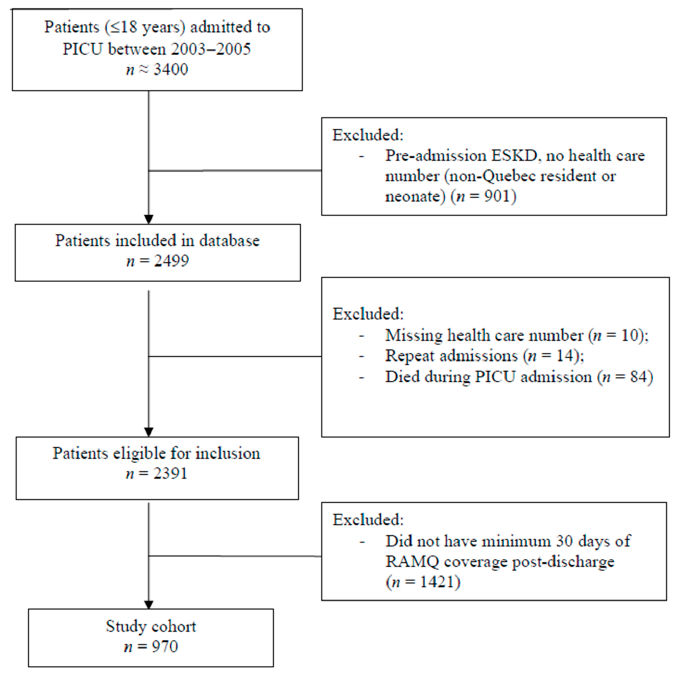
Figure 1. Flow Diagram of Patient Inclusion from the PICU and RAMQ Database. Abbreviations: PICU: pediatric intensive care unit; ESKD: end-stage kidney disease; RAMQ: Régie de l’assurance maladie du Québec